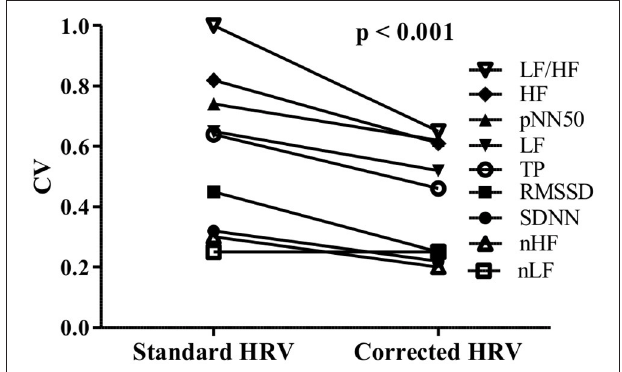
FIGURE 3 | Comparison between coefficients of variation (CV) of standard and corrected HRV